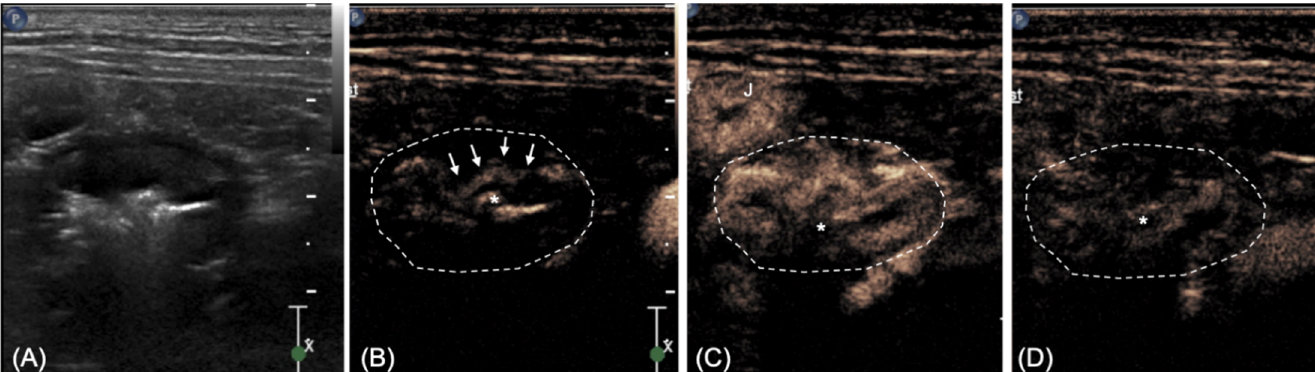
Figure 2. CEUS appearance of the descending colon at three different time points. ( A ) Bidimensional image for comparison; ( B ) arrival of the contrast media at the level of the inner layers (arrows) 9 s after injection; ( C ) peak of enhancement, more prominent at the level of the inner layers (17 s); ( D ) heterogeneous wash-out at 30 s. The margins of the colon are highlighted for more clarity. * lumen of the colon.